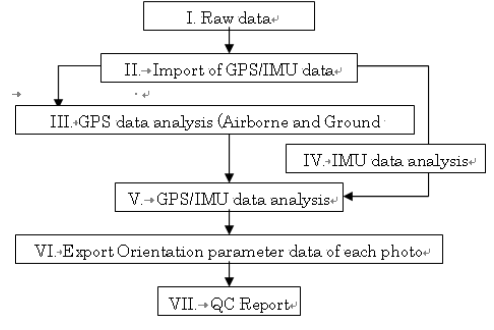
Figure 5. Workflow for GPS/IMU